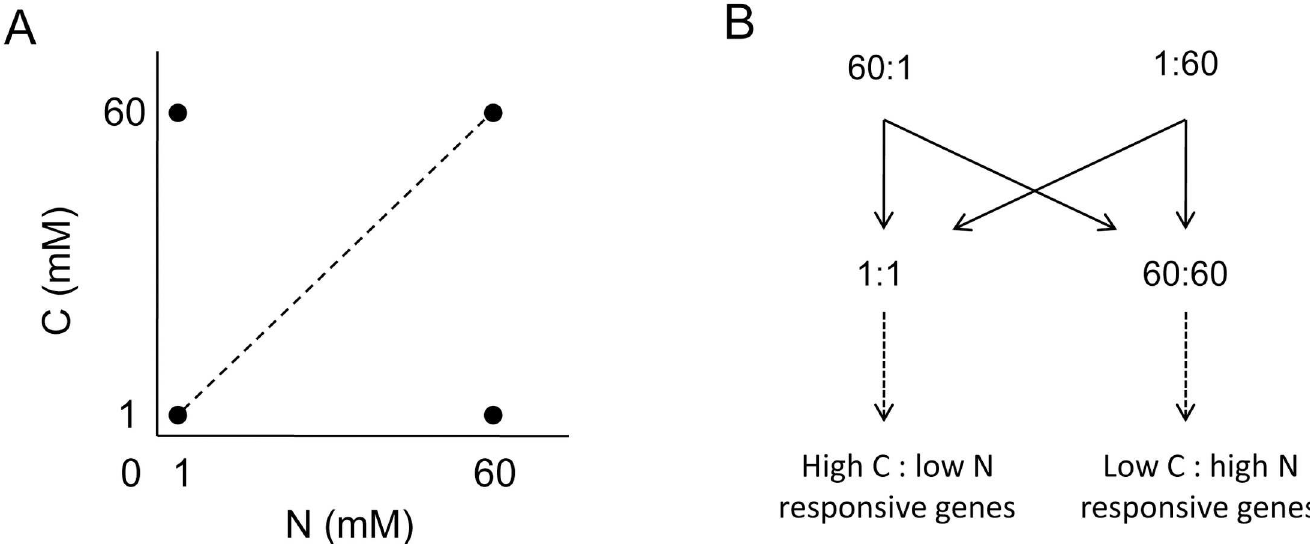
Fig 1. Experimental design to identify genes responsive to imbalanced C:N. (A) N starved rice seedlingswere treated with four different C:N conditions: balancedC:N (1:1 and 60:60) or imbalanced C:N (1:60 and 60:1). (B) Hypothetical models of genes responsiveto exogenousimbalanced C: N conditions. Genes responsive to imbalanced high C:low N (60:1) or low C:high N (1:60) are proposedto show higher or lower expressionlevels comparedwith 1:1 and 60:60 treatments.